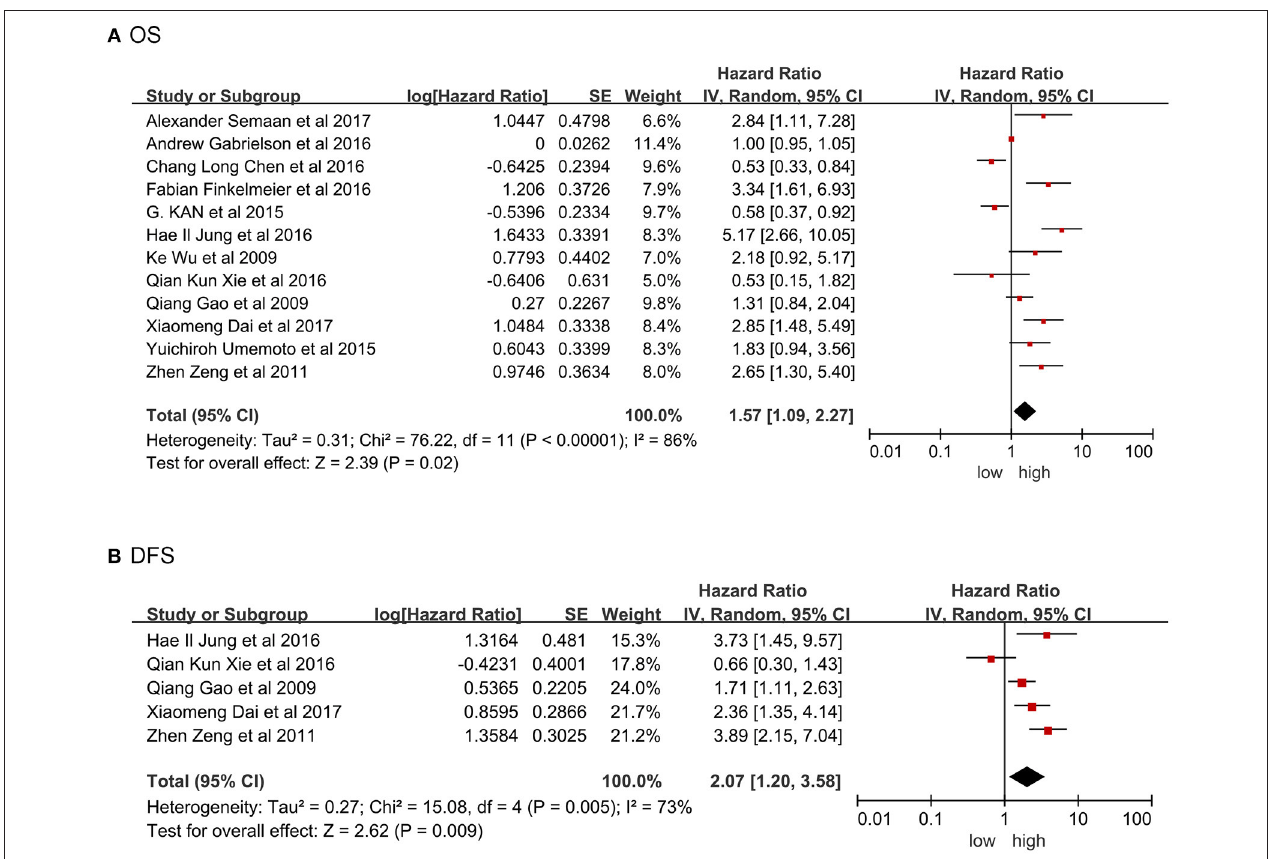
FIGURE 2 | Forrest plot of HR for OS (A) , DFS (B) . Size of the square indicates the relative contribution of each study. The solid horizontal line represents 95% confidence interval of each study. The diamond indicates pooled